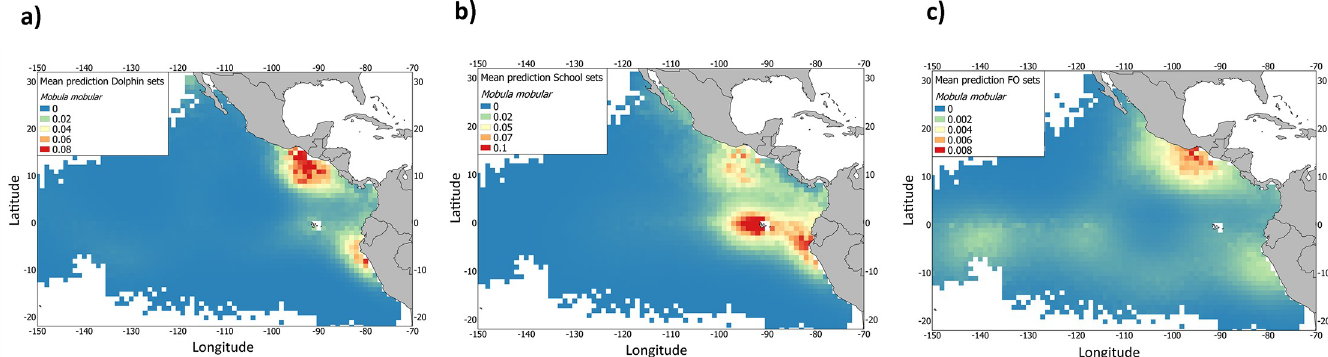
Fig 6. Mean prediction of the presence of Mobula mobular bycatch species from the tropical tuna purse-seine fishery (2005–2015) in the eastern Pacific Ocean in a) Dolphin sets, b) School sets and c) Floating object sets based on the most parsimonious model fit.